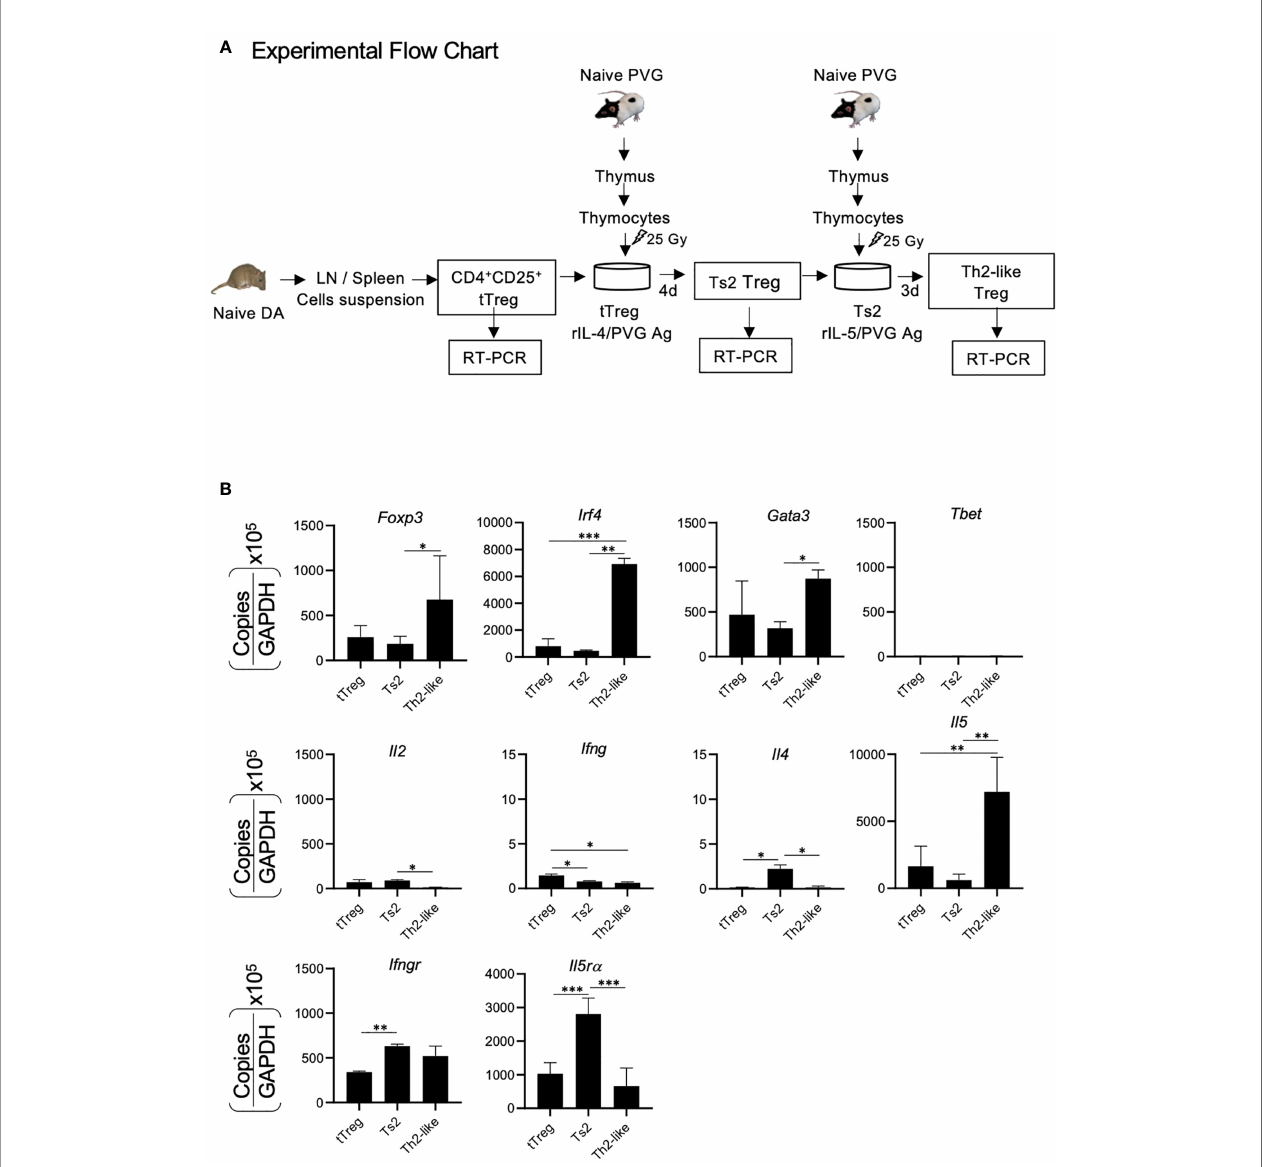
FIGURE 2 | RT-PCR of mRNA from CD4 + CD25 + T cells demonstrating changes in naïve CD4 + CD25 + T cells cultured with alloantigen and Type-2 cytokines. (A) Experimental Flow Chart. CD4 + CD25 + T cells from naïve DA rats were enriched and cultured with fully allogeneic PVG thymic stimulator cells and rIL-4 for 4 days to induce Ts2 cells that express II-5R a . These Ts2 cells were re-cultured for 3 days with same alloantigen and rIL-5 to induce the Th2-like Treg. RT-PCR was performed on mRNA from fresh naïve CD4 + CD25 + Treg and cultured activated Ts2 and Th2-like Treg to examine for transcriptions factors Foxp3, T-bet, Gata-3, Irf4; cytokines Il2, Il4, Il5, Ifng and cytokine receptors Il5ra, Ifngr . (B) Results of RT-PCR of tTreg, Ts2 and Th2 like Treg. Data shown is a combination of results from three separate experiments. Data expressed as copies for relevant molecule divided by copies of Gapdh, multiplied by 10 5. *p < 0.05, **p < 0.01, ***p < 0.001. The Th2-like Treg had greater expression of Foxp3, Irf4 and Il5 than fresh naïve CD4 + CD25 + T cells and Ts2 cells. They had more Gata-3 than Ts2 cells . Il5ra was induced in Ts2 cells but wa s not sustained in Th2-like Treg . T-bet, Ifng and ll4 were low in all samples and there was minimal Il2 (<100 copies). Expression of Irf4 and Il5 were used as markers of Th2 like Treg. The changes associated with Th1-like Treg have been described